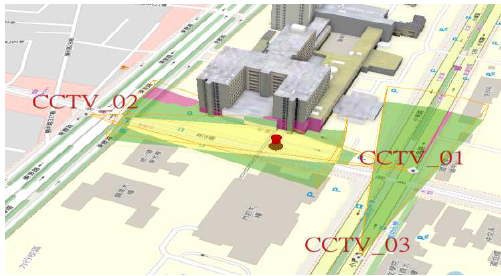
Figure 17 The visible coverage of multiple